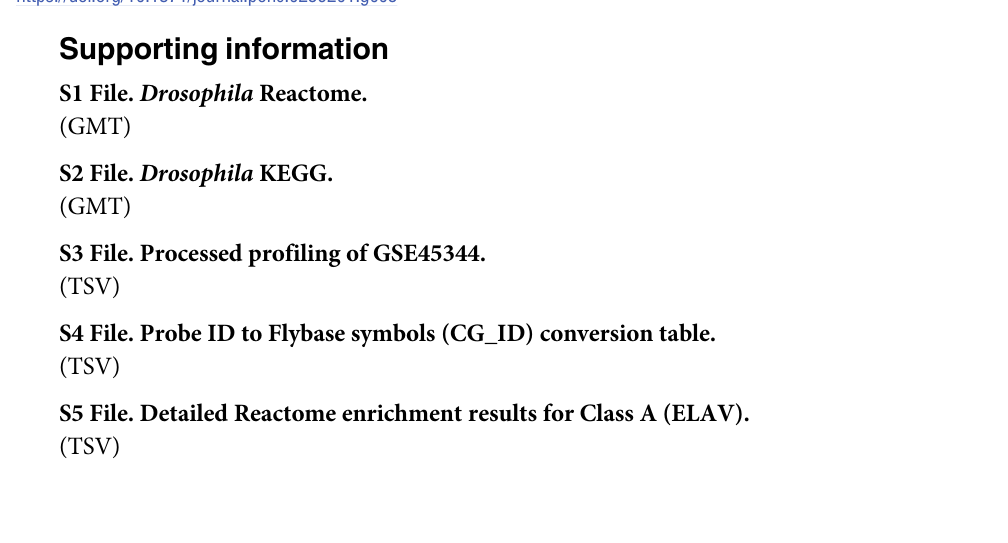
Fig 5. Representative KEGG enrichment plots of the REPO group. For each plot, the upper part shows the enrichment score; while the lower part shows ranked list metric of the gene set. The middle part shows the ranked gene list, with red meaning upregulation, blue for downregulation, and black vertical line for the genes of the set.